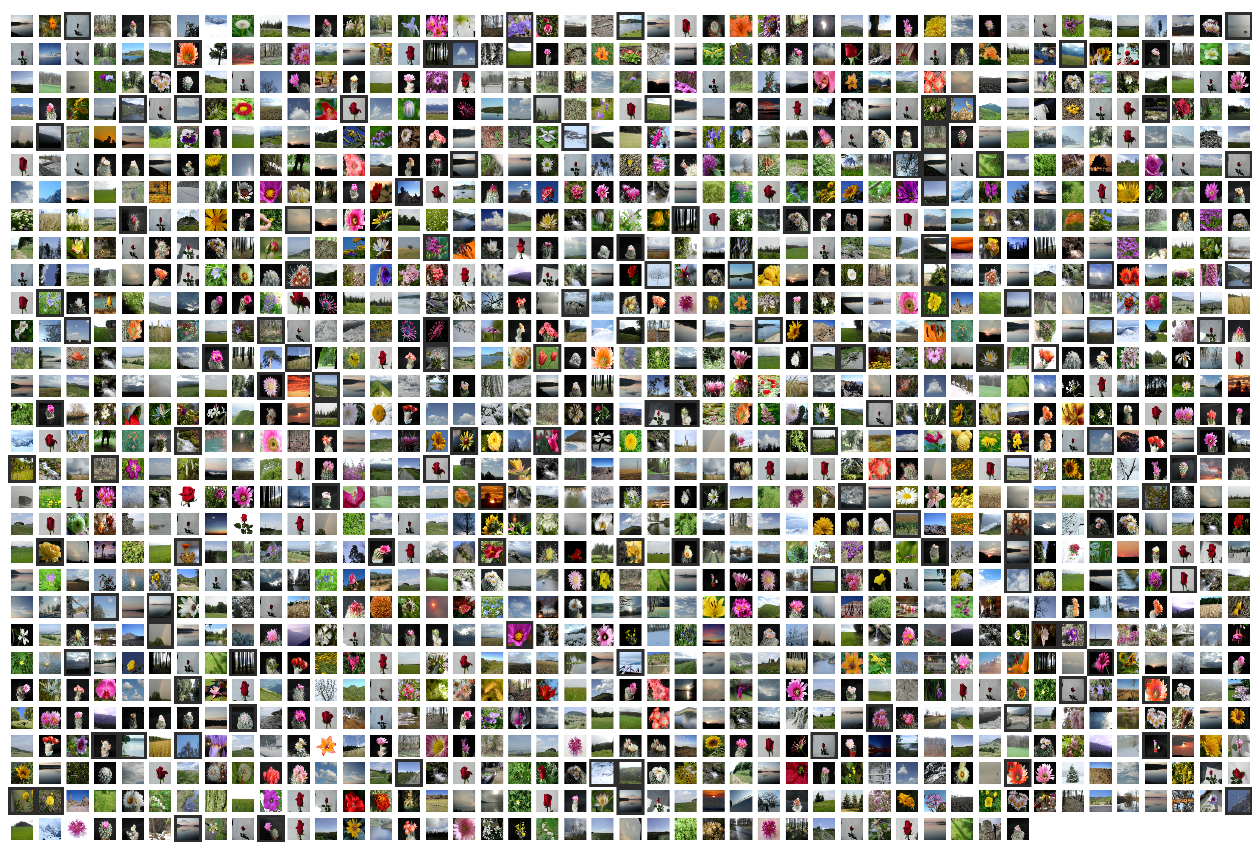
Figure 5. Image collection with hidden imagechain (pictures with dark borders).